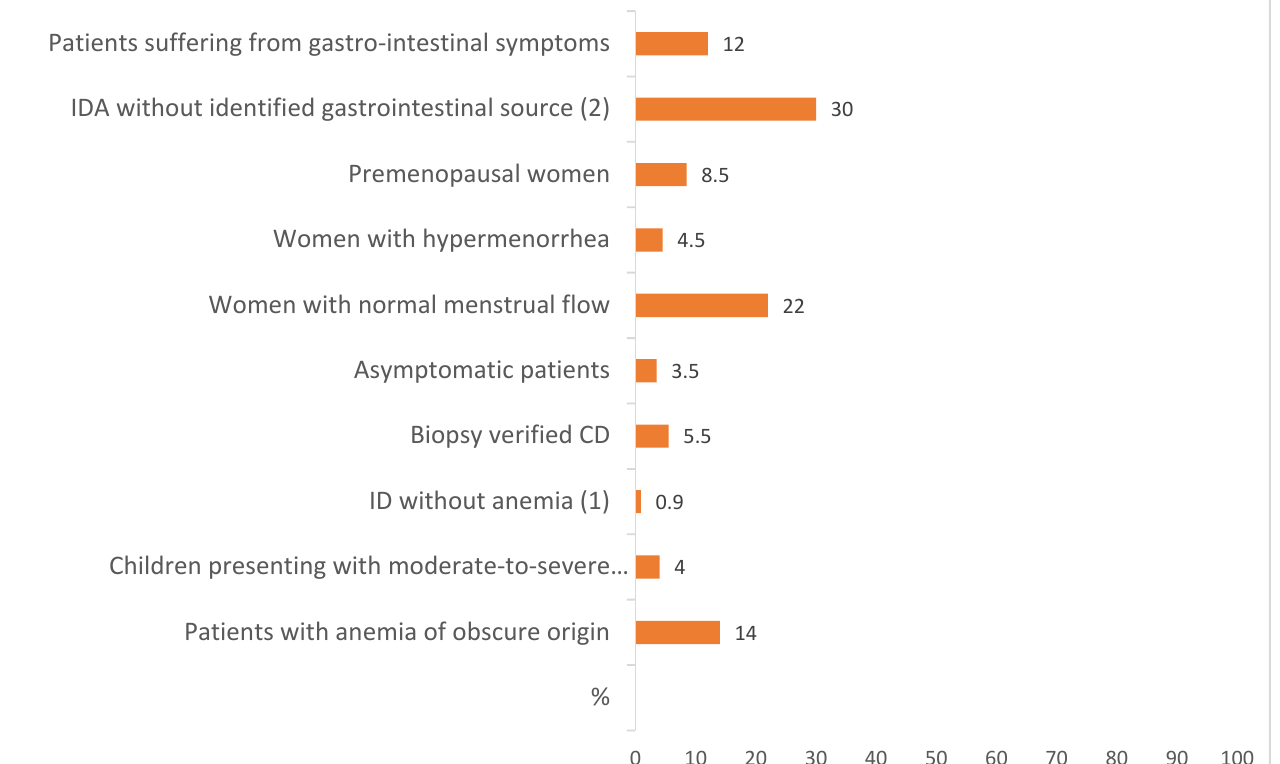
Figure 2. Prevalence of CD in patients with IDA in different setting. (1) OR of 12.5 (95% CI 1.74–90) (compared to the prevalence of CD controls); (2) Diagnosis celiac desease based on serology results without duodenal biopsy.